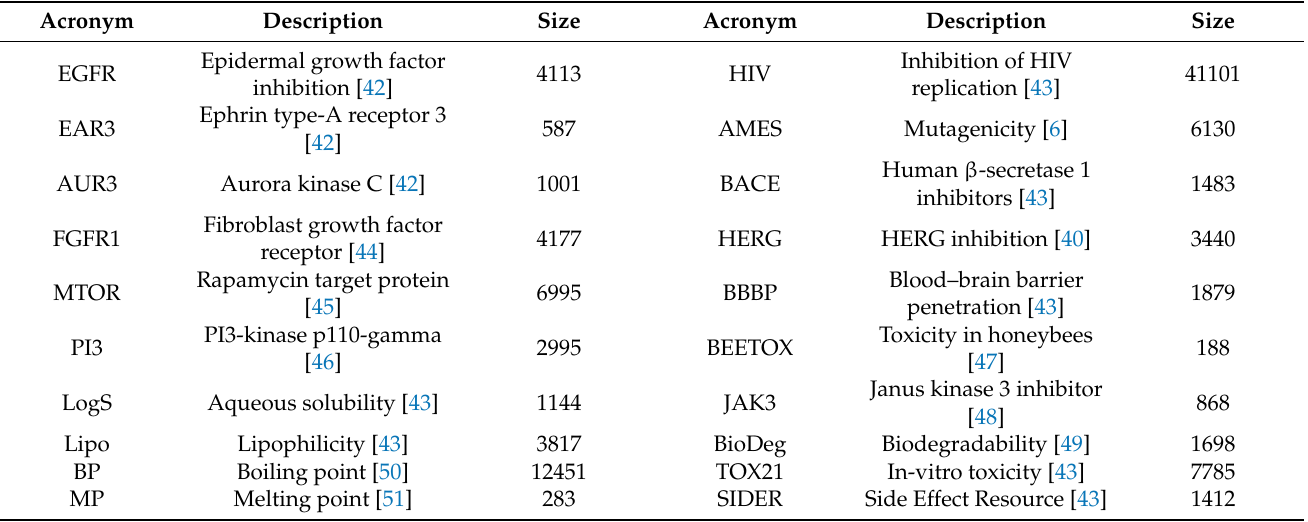
Table 7. Overview of the datasets of drug properties (left for regression and right for